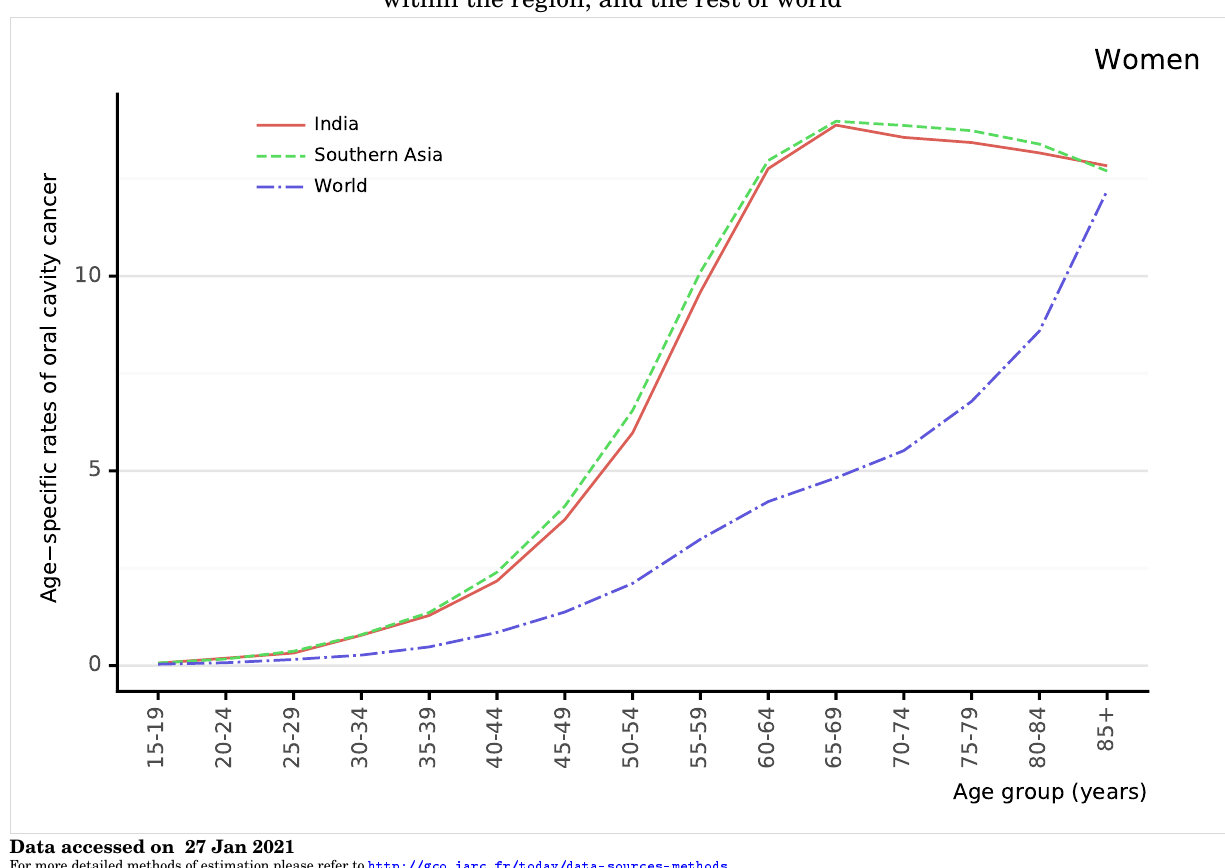
Figure 131: Comparison of age-specific oral cavity cancer mortality rates among women by age in India, within the region, and the rest of